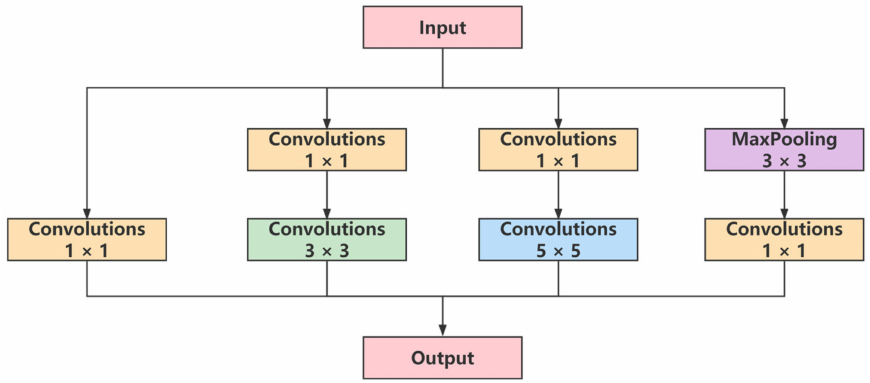
Figure 8. Inception v1 structure